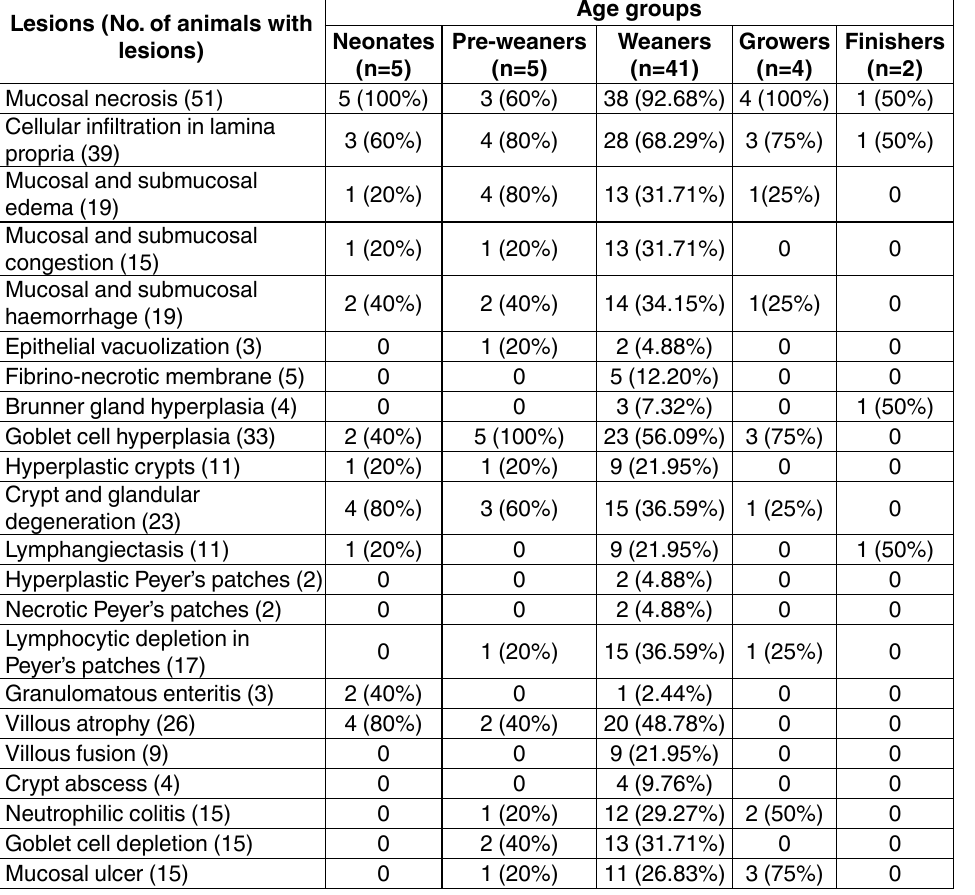
table 4. Age-wise occurrence of histopathological changes in intestines lesions (No. of animals